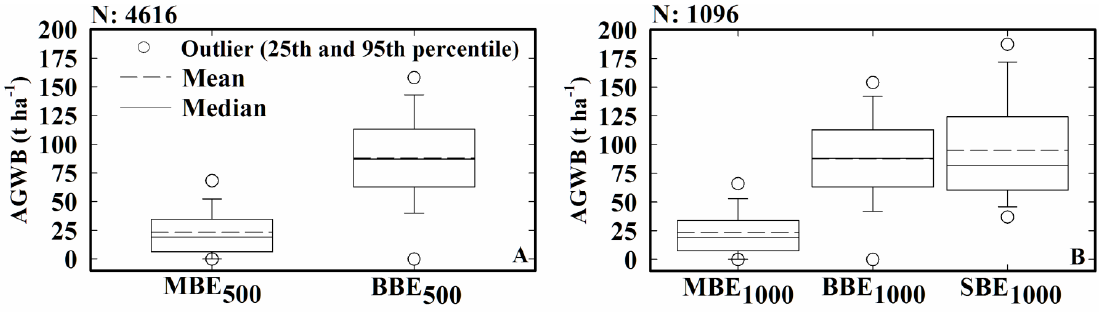
Figure 8. Differences between biomass maps for ( A ) 500-m and ( B ) 1000-m